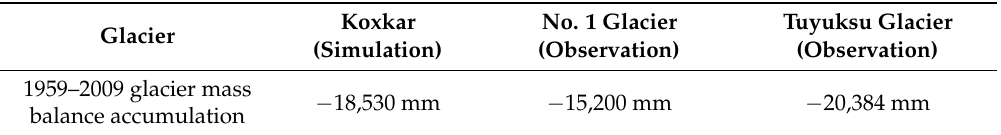
Table 4. Comparison of simulated and observed glacier mass balance accumulation between Koxkar Glacier and adjacent glaciers.